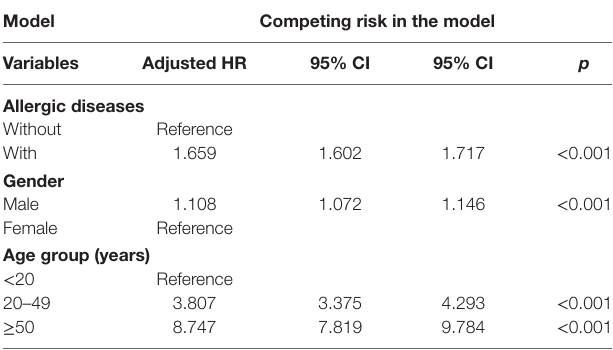
TaBle 2 | Factors of psychiatric disorders by using Fine and Gray’s competing risk model.